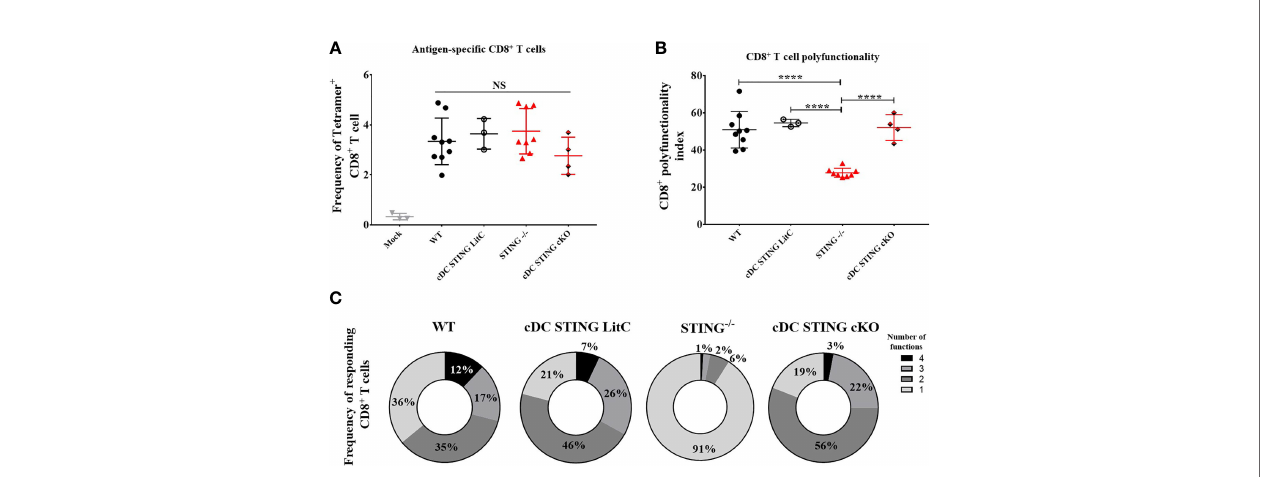
FIGURE 3 | STING is not required within conventional dendritic cells to mediate DNA vaccine induction of CD8 + T cell responses. WT, STING -/- , zbtb46 Cre xSTING fl / fl